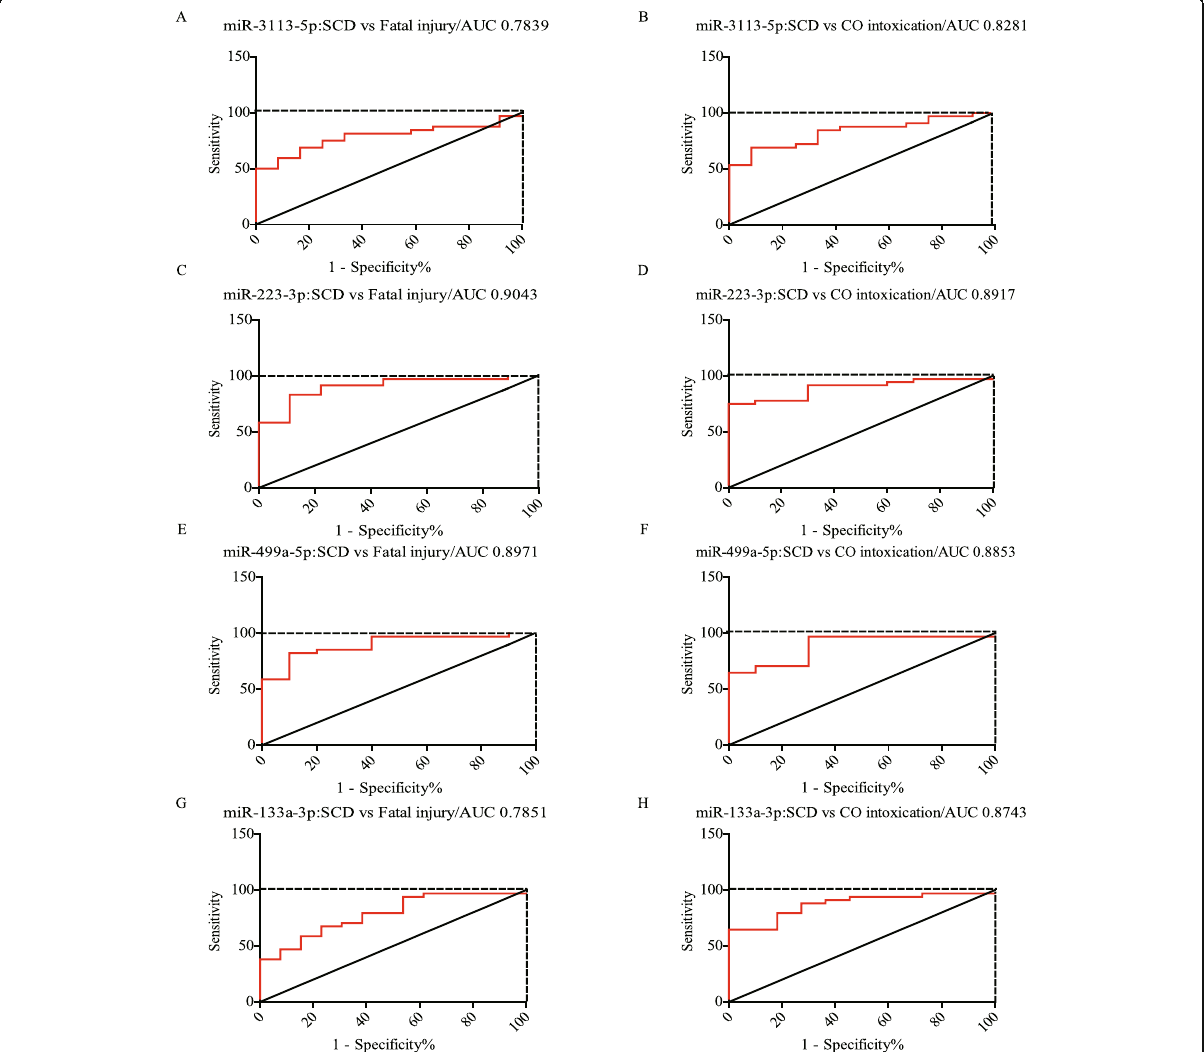
Fig. 4 Diagnostic performance of the four miRNAs were analyzed by ROC curve. (A, B) ROC curve of miR-3113-5p. (C, D) ROC curve of miR-223- 3p. (E, F) ROC curve of miR-499a-5p. (G, H) ROC curve of miR-133a-3p